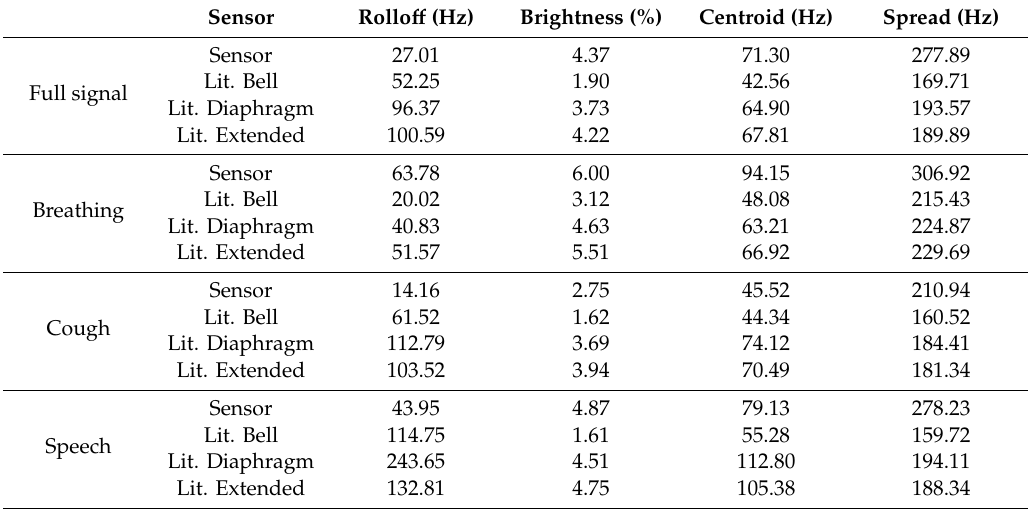
Table 1. Extracted features with respiratory sounds recorded in position